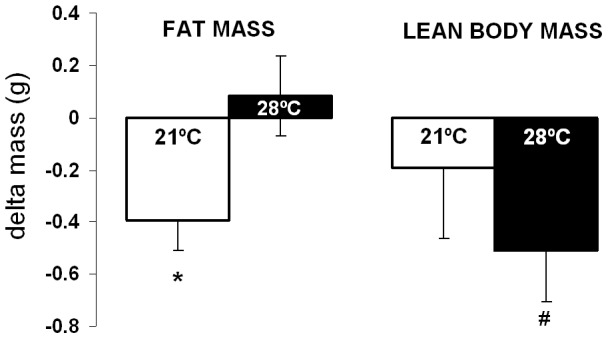
Change in body composition.Change in fat mass and lean body mass at the end of the study relative to baseline body composition. Mice housed at 21°C (white bars, n = 8) throughout the study are compared to mice housed at 28°C (black bars, n = 8) throughout all phases of the study. Data are shown as means ± SEM with * showing p<0.05 by both paired (within-group relative to baseline) and unpaired (between group) Student's t-test and # showing p<0.05 by paired Student's t-test.